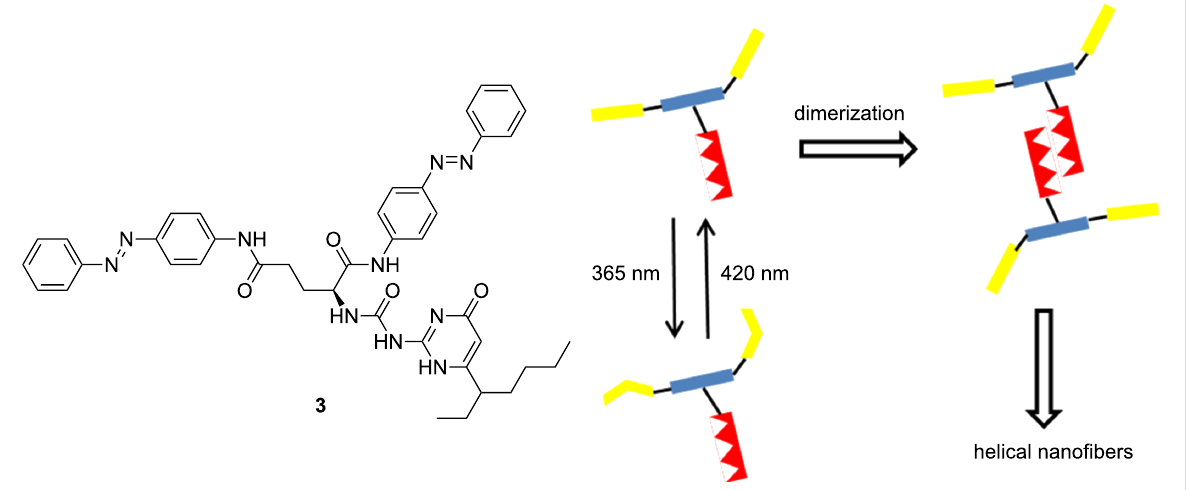
Figure 1: The chemical structure and the schematic representation of compound 3 as well as the proposed assembly process of the nanostructure.